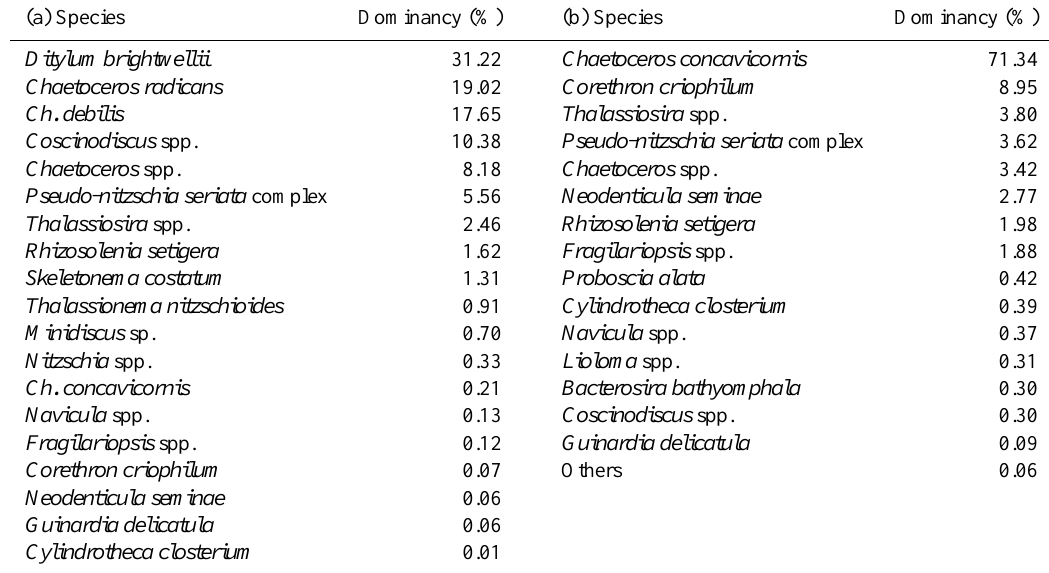
Table 2. Dominant micro-sized diatoms off (a) Sakhalin Island and (b) the Kuril Islands in terms of carbon biomass a . (a) Species